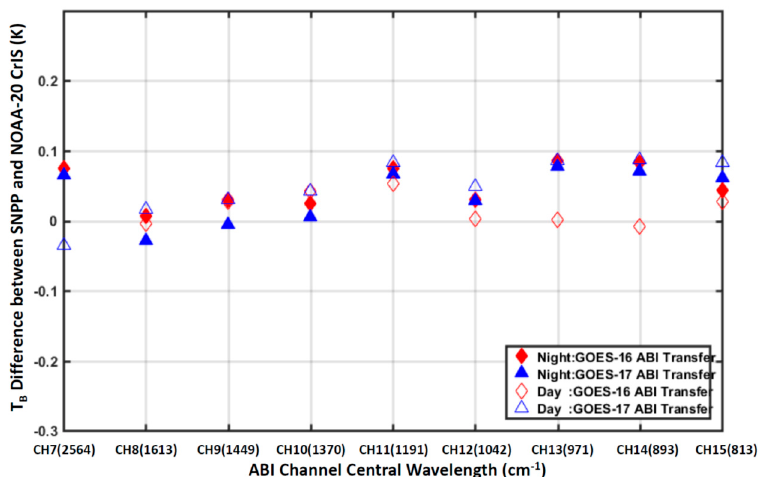
Figure 11. Comparison of SNPP and NOAA-20 CrIS inter-sensor calibration radiometric biases at 2211 channels spanning wavenumbers from 650 to 2545 cm − 1 using the methods of 32D-AD and ABI-DD, where the data cover the period from 27 September to 28 October 2019. The results with ‘Night’ and ‘Day’ in the figure correspond to the data in descending and ascending nodes,